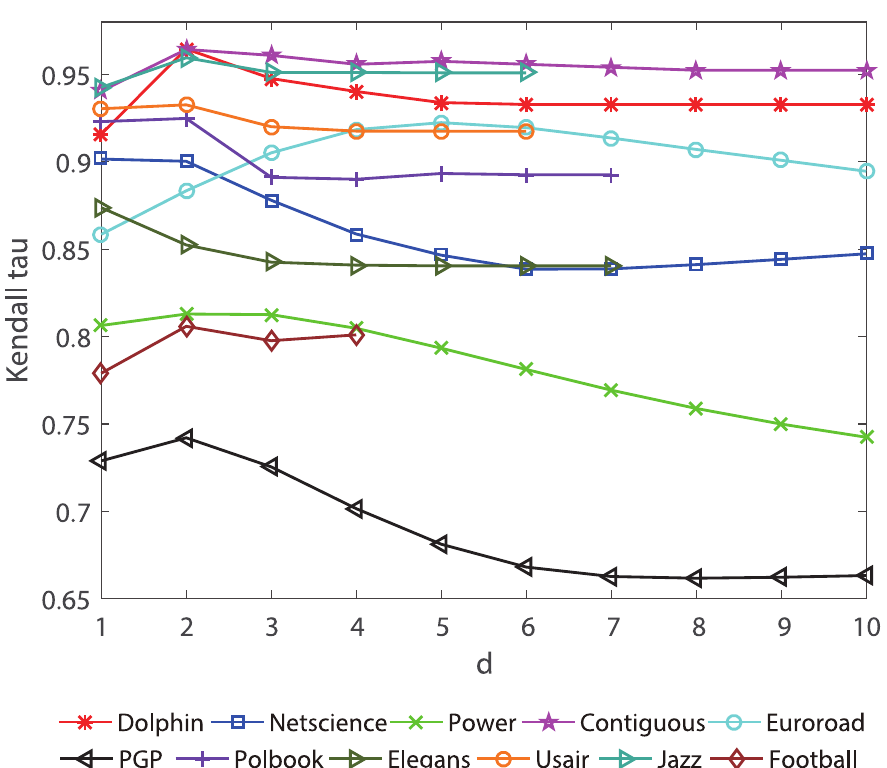
Fig 2. The effects of different parameter d . The results are obtained under a series of neighborhood distance range ranges from 1 to 10 on the eleven networks by calculating the kendall’s τ between the SIR epidemic ranking list and the Lhc ranking list